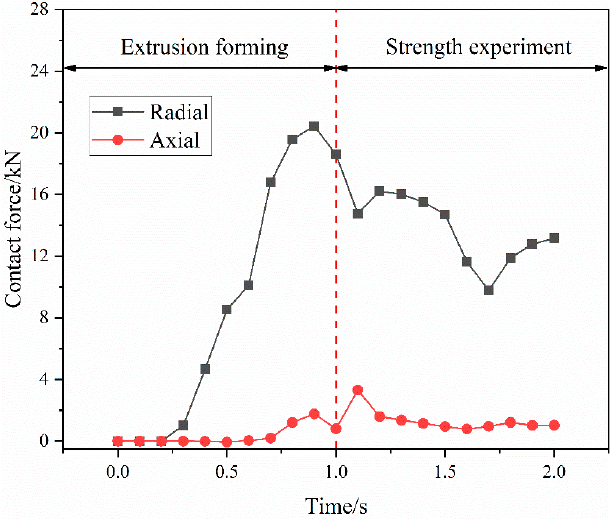
Figure 10 illustrates the contact-force variation curve between the fittings body and titanium tube during the connection process. In the extrusion-forming stage, the contact force between the fittings body and the titanium tube increases gradually and the radial force is much larger than the axial force. At the end of the extrusion process, a constant residual contact force is maintained between the fittings body and the titanium tube, with a radial contact force of 18.58 kN and an axial contact force of 0.81 kN. The contact between the fittings body and the titanium tube is tight. After the connection-strength experiment, the contact state between the fittings body and the titanium tube is destroyed. The radial contact force drops sharply and the axial contact force shows a trend of increasing and then decreasing with time. The increased axial contact force between the fittings body and the titanium tube is caused by the pull-off resistance of the titanium-tube material embedded in the groove of the fittings body. Therefore, the connection strength of the joint is formed by both the radial contact force between the titanium tube and the fittings body and the axial pull-off resistance of the titanium-tube material embedded in the groove of the joint body, in which the radial contact force is the main part.